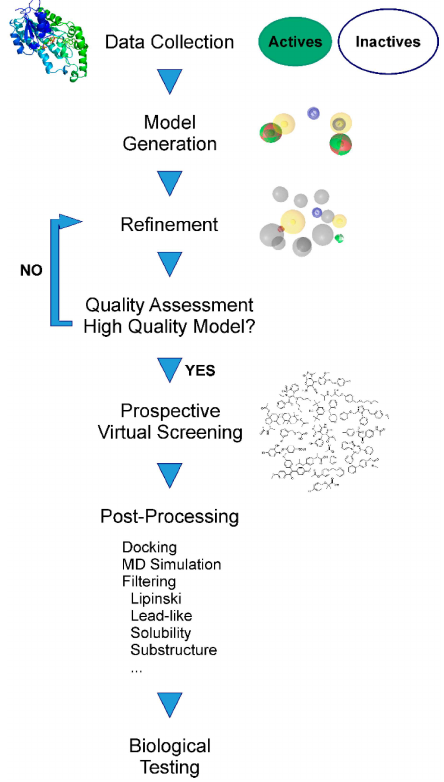
Figure 4. The different consecutive steps in pharmacophore model generation, refinement, and prospective